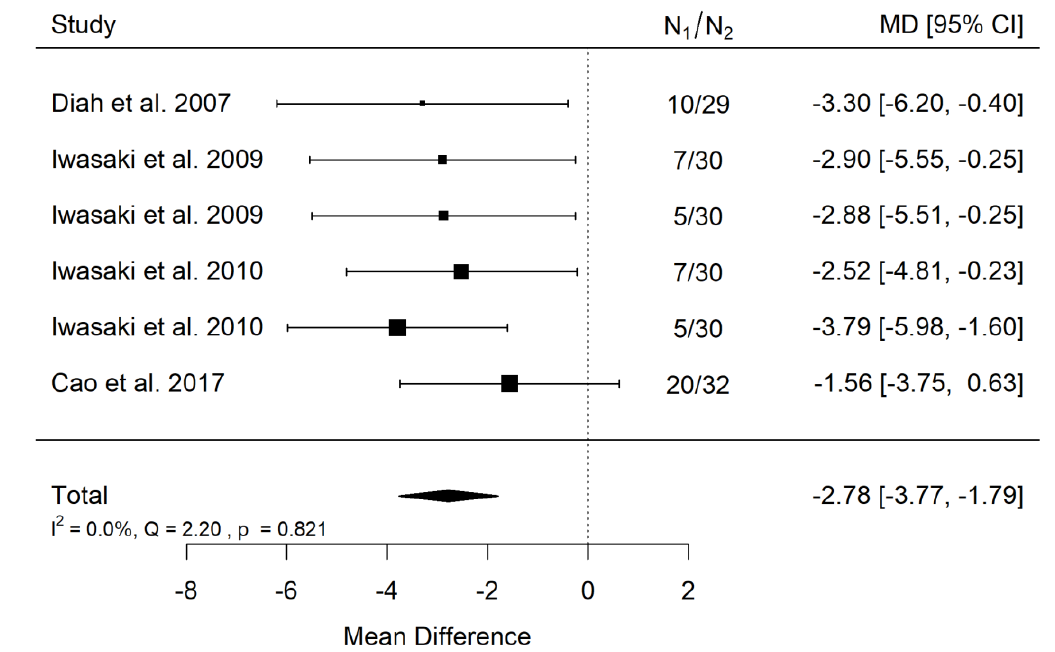
Figure 6. Forest plot of SNA values for the comparison of patients with untreated submucous cleft palate vs. non-cleft healthy population [18,21,24,25].